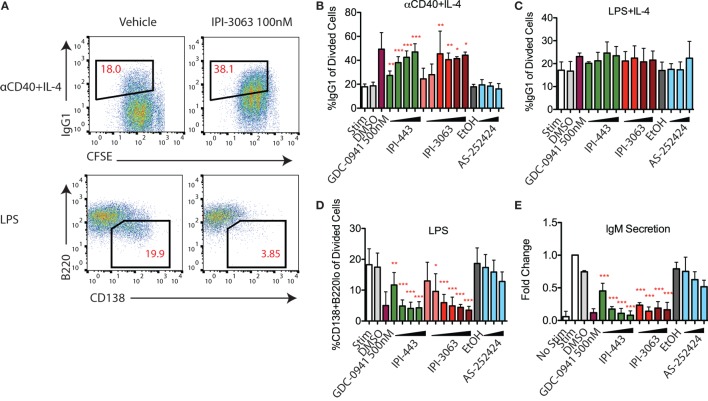
IPI-3063 potently promotes mouse B cell antibody switching and inhibits plasmablast differentiation. Purified B cells were pretreated with inhibitors, then stimulated with αCD40 + IL-4 (B) or LPS + IL-4 (C) for 96 h to induce switching to IgG1 or LPS (D) for 72 h to induce plasmablast differentiation. Class switching to IgG1 was measured by the 7AAD−CFSEloB220+IgG1+ cells [(A), upper panels]. Plasmablast percentages were calculated by % 7AAD−CFSEloCD138+B220lo population [(A), lower]. Supernatant was harvested (E) for IgM ELISA. Concentrations used were 1 nM, 10 nM, 100 nM, 1 µM for IPI-443 and 1, 10, 30, 100 nM for IPI-3063. Low concentrations of IPI-3063 were 0.01 and 0.1 nM (D). AS252424 concentrations were 100 nM, 300 nM, and 1 µM, and GDC-0941 was at 500 nM. Samples were collected by time (*P < 0.05, **P < 0.001, ***P < 0.0001 one-way ANOVA with Newman–Keuls multiple comparison test).